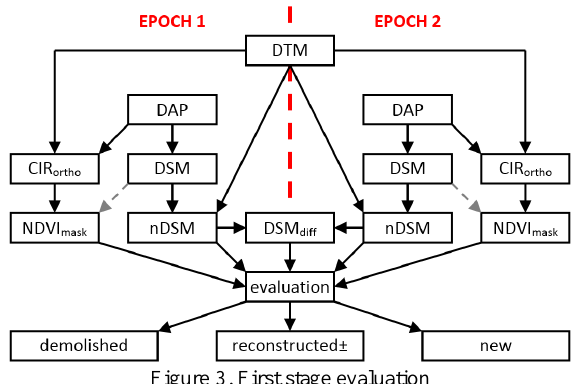
Figure 3. First stage